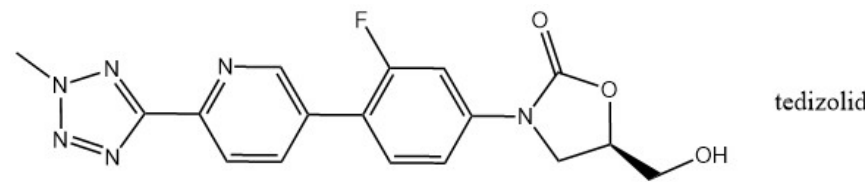
Figure 1. The chemical structures of the analyte, tedizolid.